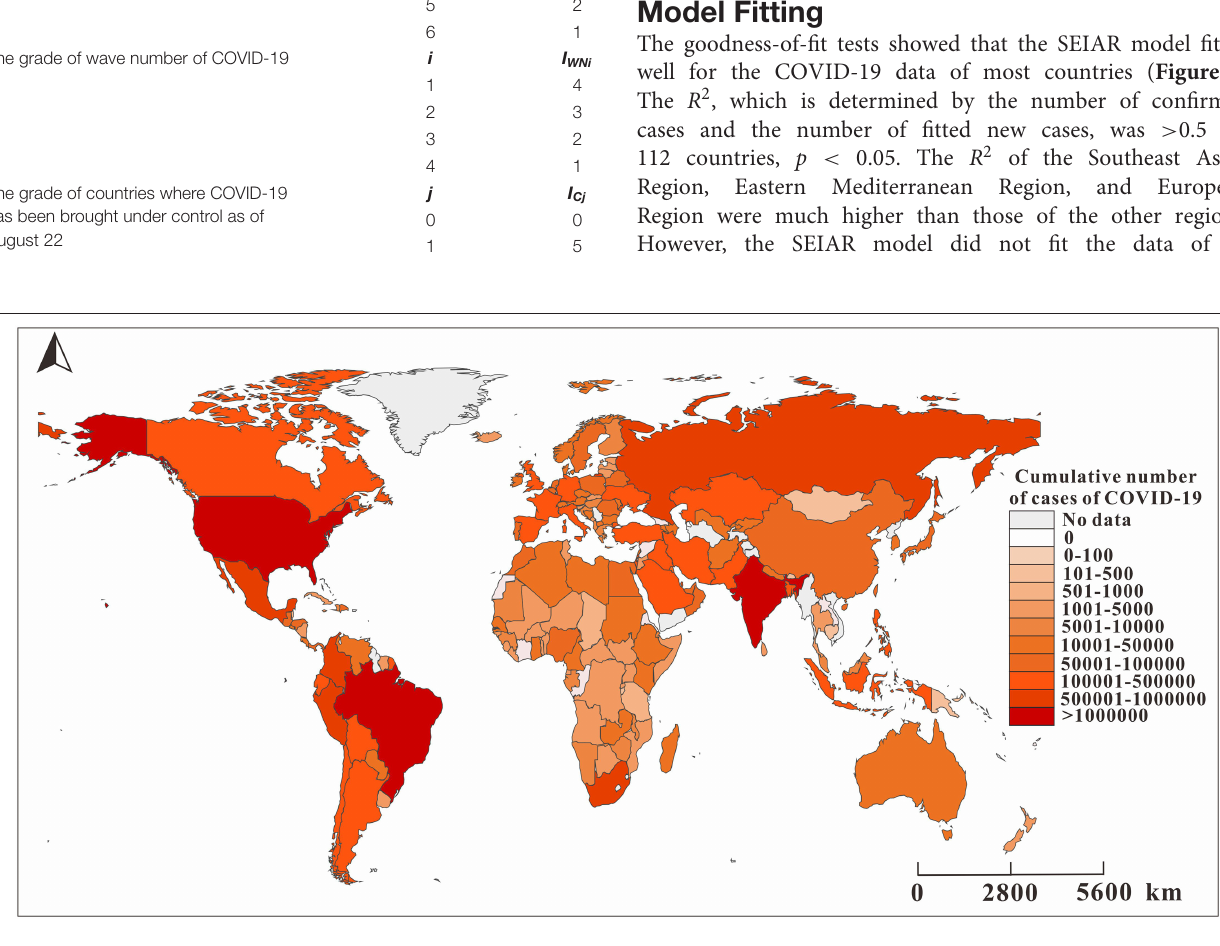
Frontiers in Medicine |